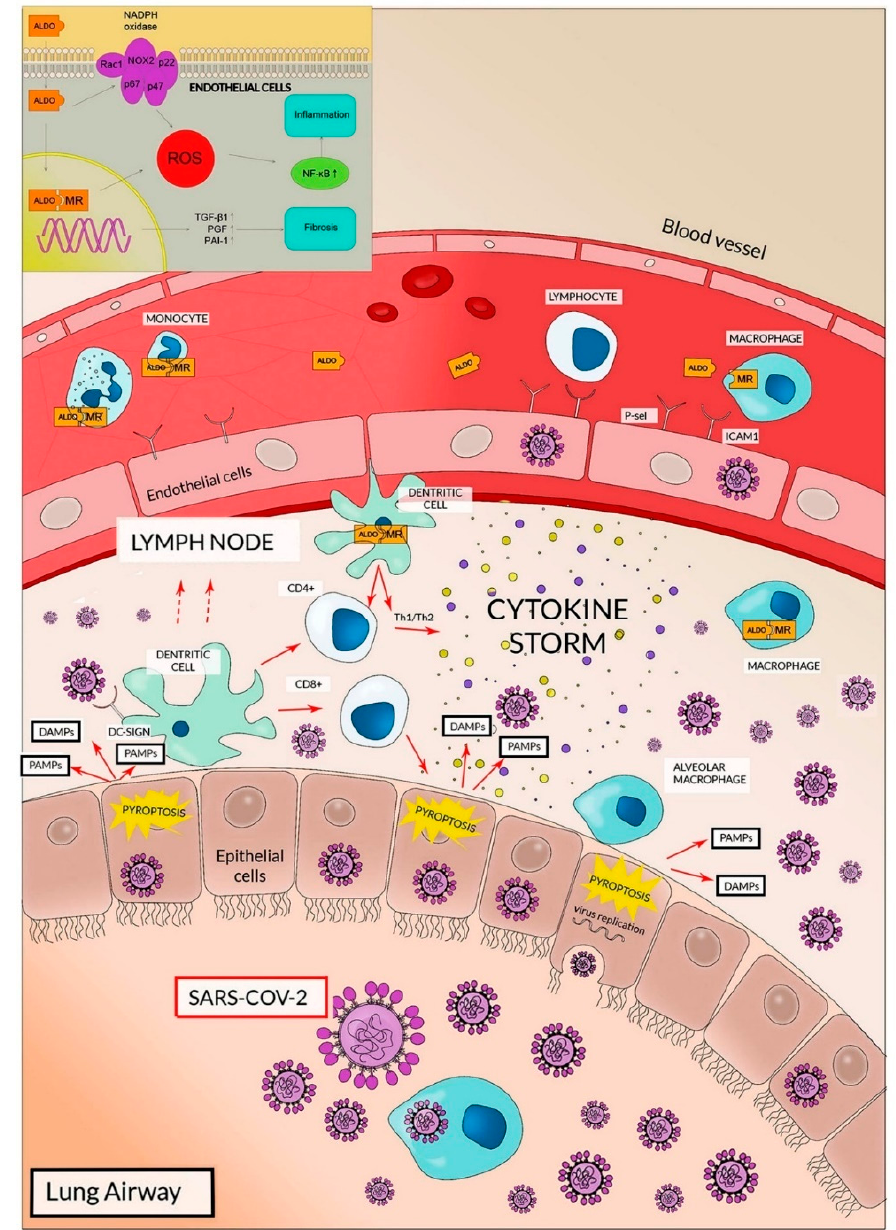
Figure 2. Scheme summarizing the possible involvement of dendritic cells in SARS-CoV-2 infection. Pneumocytes are infected by SARS-CoV-2 and, after pyroptosis, release viruses, PAMP (pathogen-associated molecular patterns) and DAMPS (damage-associated molecular patterns). PAMPs and DAMPs might activate dendritic cells. Moreover, DC-SIGN (localized on dendritic cells) might recognize and bind the virus. Then, dendritic cells might move toward lymph nodes. Locally, dendritic cells might a ff ect di ff erent populations of T-lymphocytes. SARS-CoV-2 might also increase, through RAAS (renin-angiotensin-aldosterone system), the production of aldosterone (ALDO) that is intracellularly recognized by its receptor (MR) (see the text for more mechanistic details). In turn, this results in an activation of dendritic cells and macrophages. Aldosterone could also a ff ect coagulation enhancing microthrombosis. SARS-CoV-2 also infects endothelial cells, causing hypercoagulation and a ff ecting dendritic cells. The image also shows the cytokine storms that are due to the activation of a plethora of cells, including those of innate immunity response. In the inset, aldosterone stimulation of endothelial cells NADPH oxidases with a concomitant ROS production is shown. ROS might be also involved in the hyperinflammation